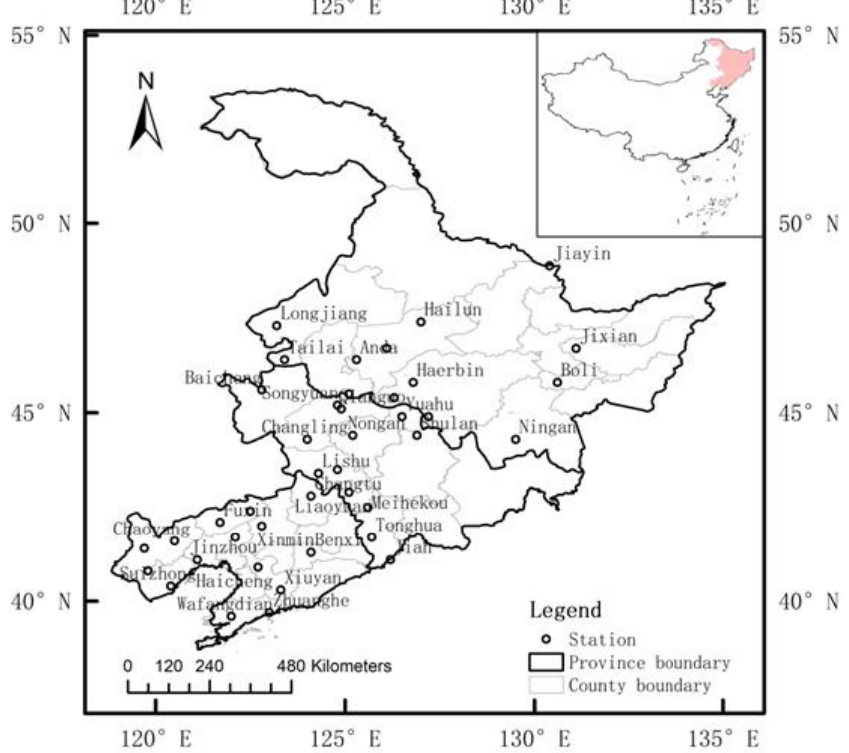
Figure 1. Spatial distribution of agro-meteorological observation stations in northern China.